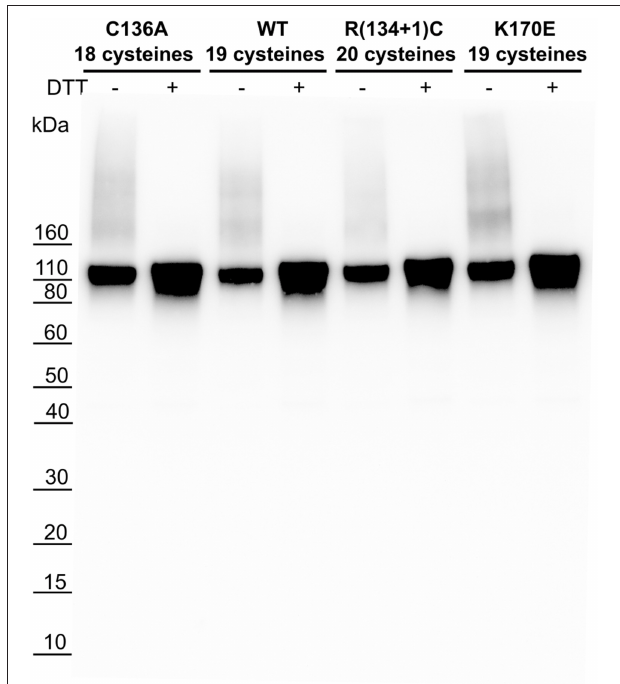
FIGURE 3 | HEK293 GnTI- expression of recombinant gp120 EN3d071 WT and mutants. Recombinant gp120 sequences EN3d071 C136A